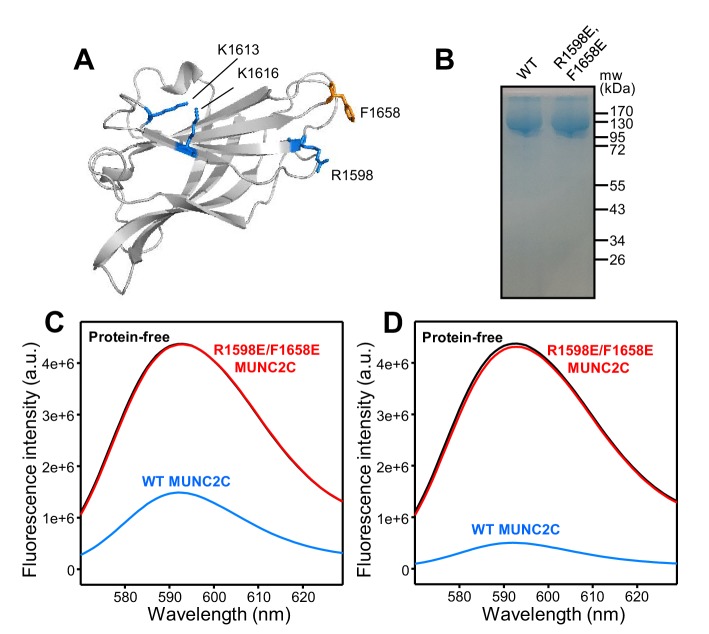
The MUNC2C fragment binds to liposomes.(A) Ribbon diagram of a structural model of the Munc13-1 C2C domain built based on the crystal structure of the RIM1 C2B domain (Guan et al., 2007) (PDB accession code 2Q3X) and the sequence homology between the two C2 domains. The side chains of the residues that were mutated in this study are shown as stick models. (B) Analysis of the resins used for GST-pulldown assays of liposome binding. Equal amounts of GST-affinity resins loaded with WT or R1598E/F1658E MUNC2C were analyzed by SDS-PAGE and coomassie blue staining. (C,D) Fluorescence emission spectra showing that GST-affinity resins loaded with WT MUNC2C bind to rho-liposomes and that the R1598E/F1658E mutation abolishes binding. GST-affinity resins that were protein free (black curves) or were loaded with WT MUNC2C (blue curves) or R1598E/F1658E MUNC2C (red curves) were incubated with rho-liposomes. The WT and mutant GST-MUNC2C resins were loaded with four-fold larger amounts of proteins for the experiments of panel (D) than for those of panel (C). Samples were centrifuged and fluorescence emission spectra of the flow through were acquired. Note that comparable amounts of rho-liposomes were eluted from the protein-free and R1598E/F1658E GST-MUNC2C resins, whereas much less rho-liposomes were eluted from the WT GST-MUNC2C resins.